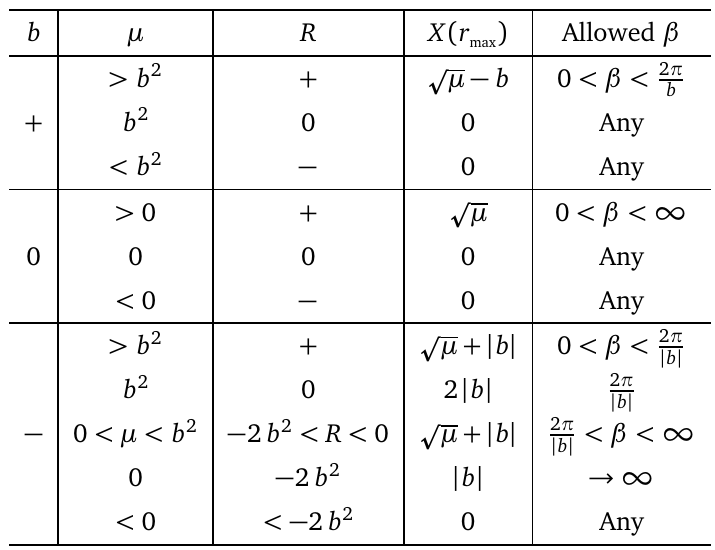
Table 1: Properties of solutions in Schwarzschild gauge. The second